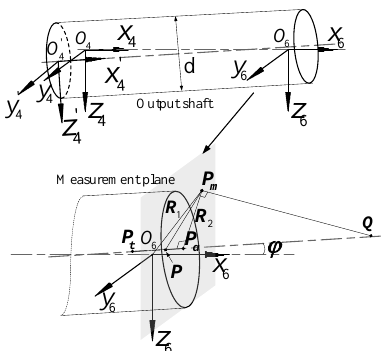
Figure 4. Geometric relationship of the measurement point under errors.